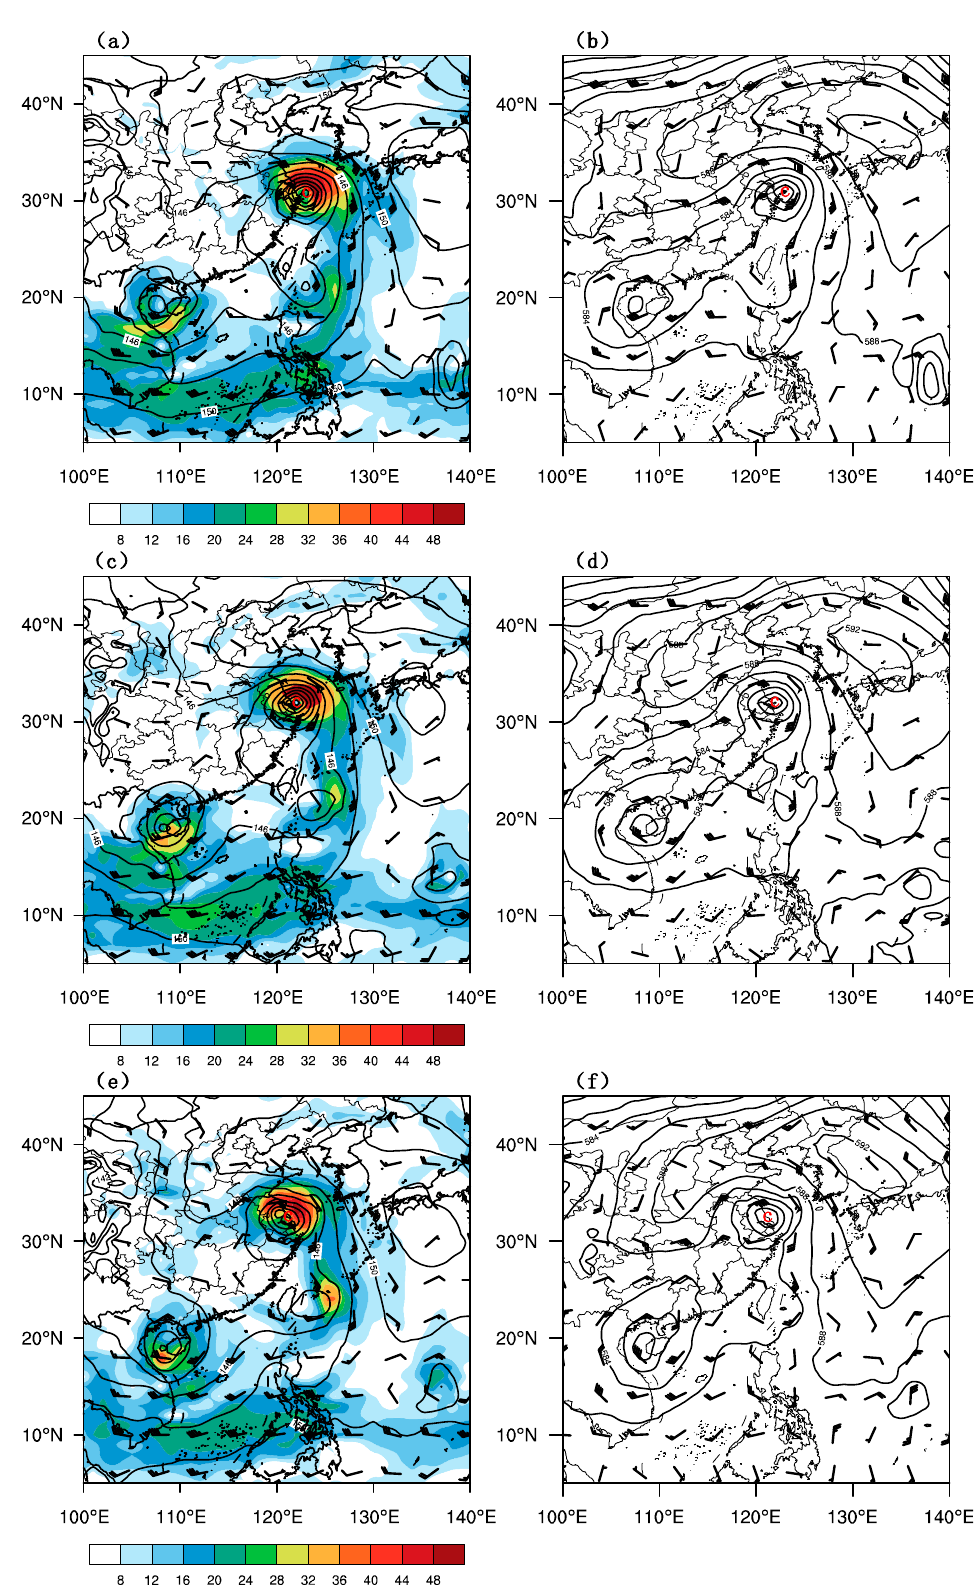
Figure 2. ( a , c , e ) The 850 hPa circulation including geopotential height (lines, unit: dagpm), specific humidity (shading, unit: g/kg), and wind field (vectors, unit: m/s) and ( b , d , f ) the 500 hPa circulation including geopotential height (lines, unit: dagpm) and wind field (vectors, unit: m/s) at ( a , b ) 0000 UTC, ( c , d ) 0600 UTC, ( e , f ) 1200 UTC on 22 July 2018. Red “C” represents the center of tropical storm Ampil at each corresponding